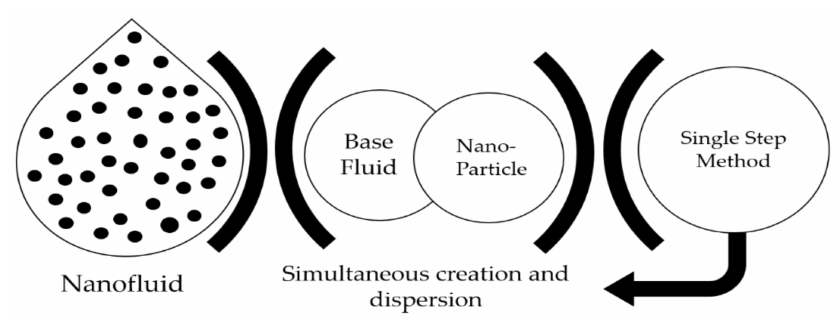
Figure 2. Single step method.